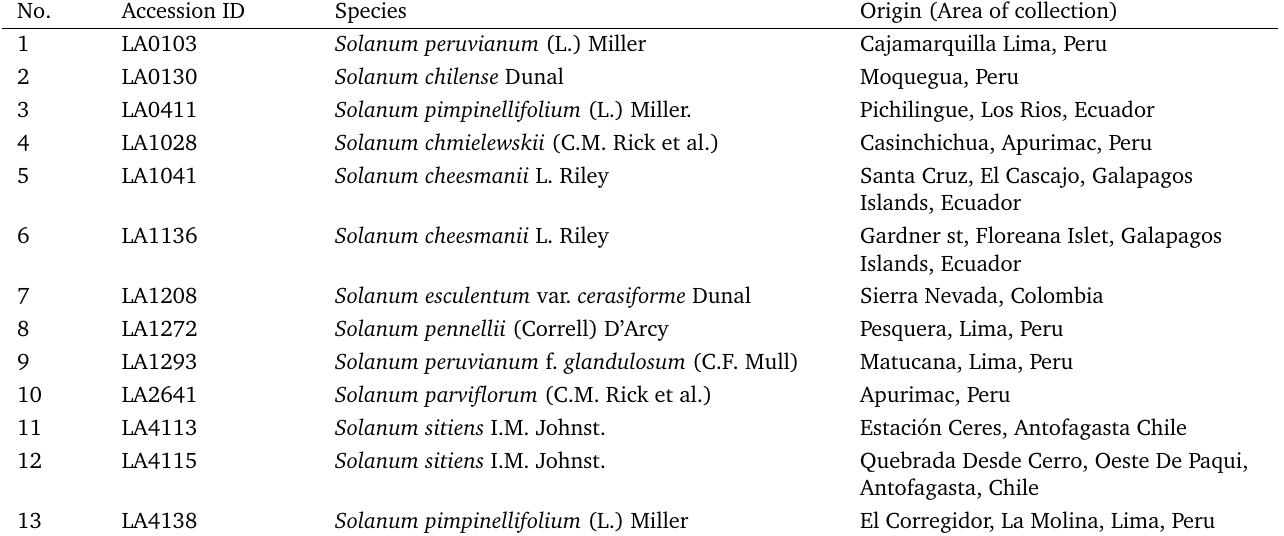
Table 1. Description of the 13 species of wild tomato accessions used for the